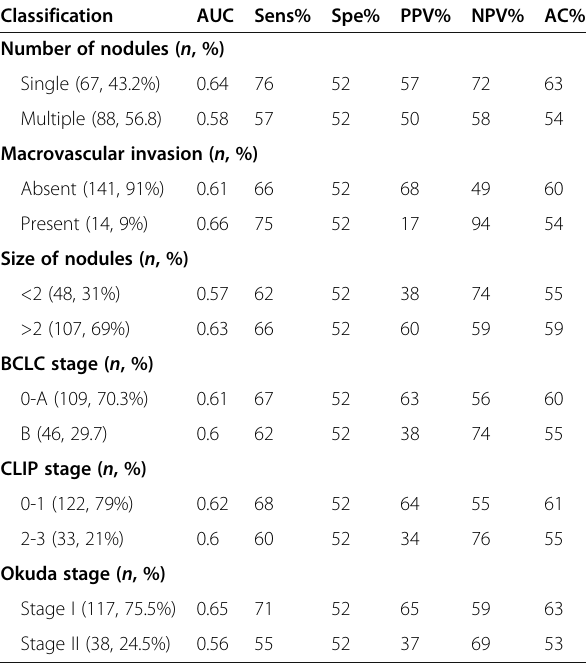
Table 6 Diagnostic power of IGF2 to discriminate patients with HCC from patients with cirrhosis in different three staging